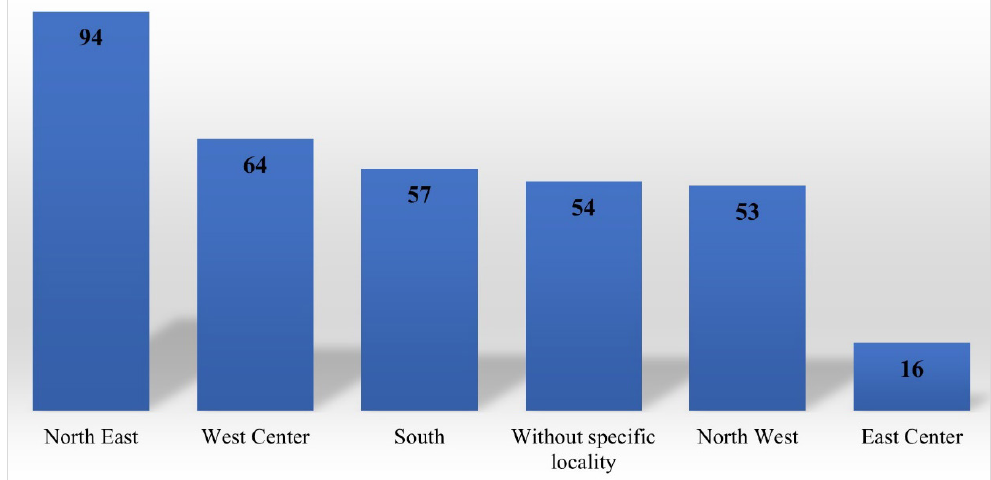
Fig 4. Apidae species number per region in Table 1 . Endemic and near endemic Apidae species in Tunisia. The symbol “+” means presence. Species Algeria Libya Morocco Tunisia